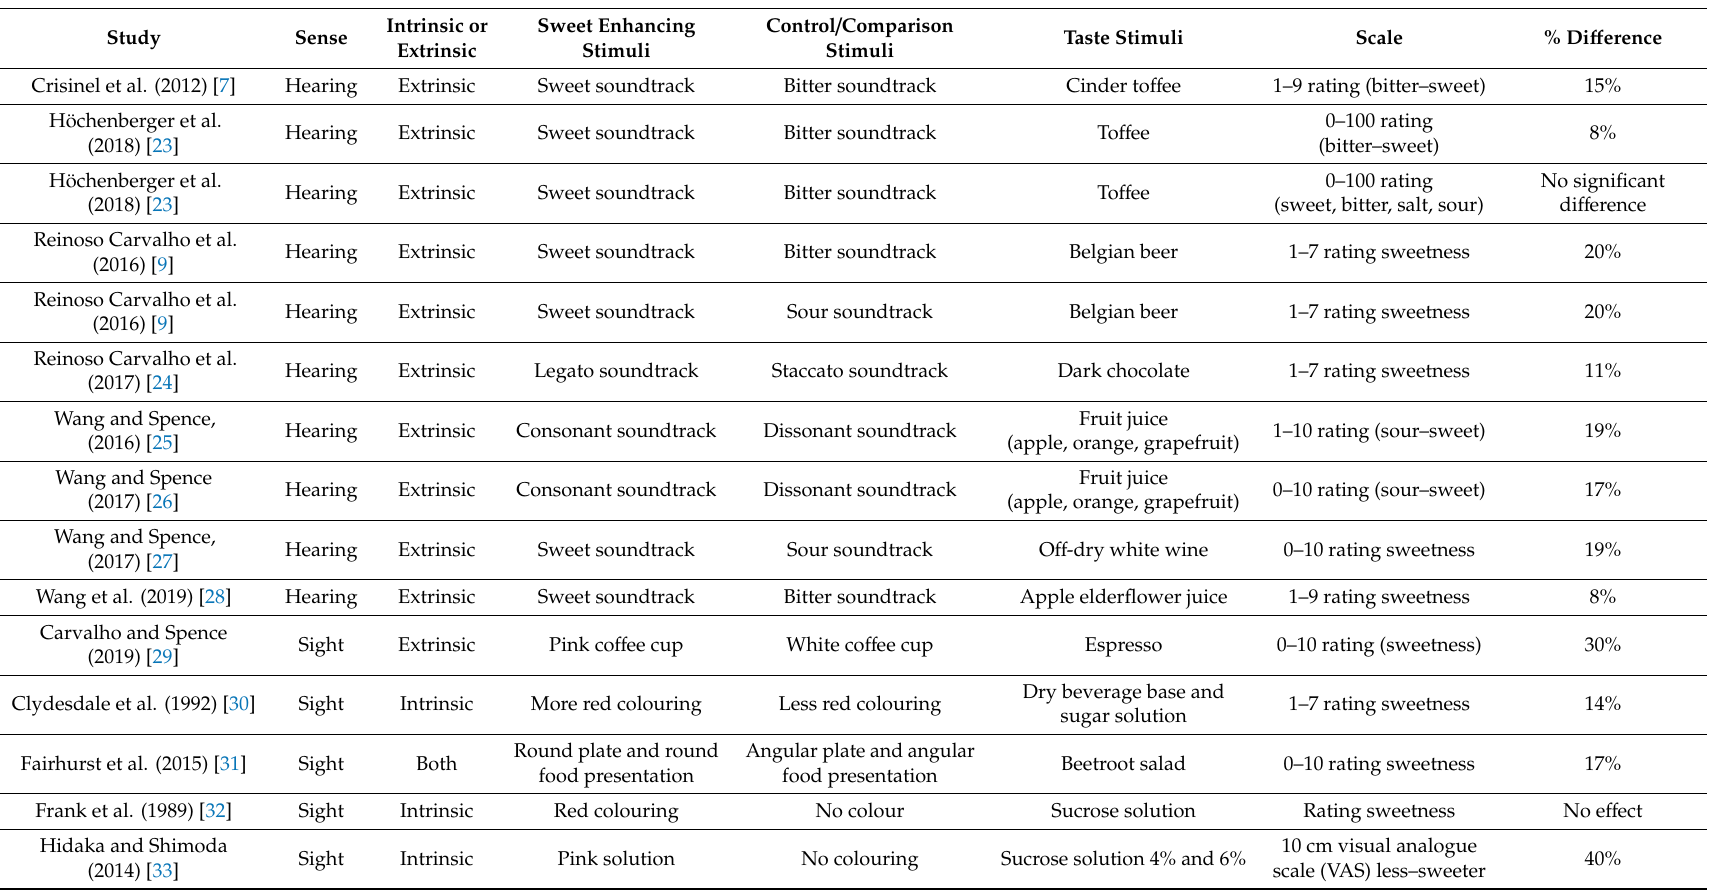
Table 1. A representative selection of studies demonstrating sweetness enhancement via food-intrinsic and extrinsic sensory